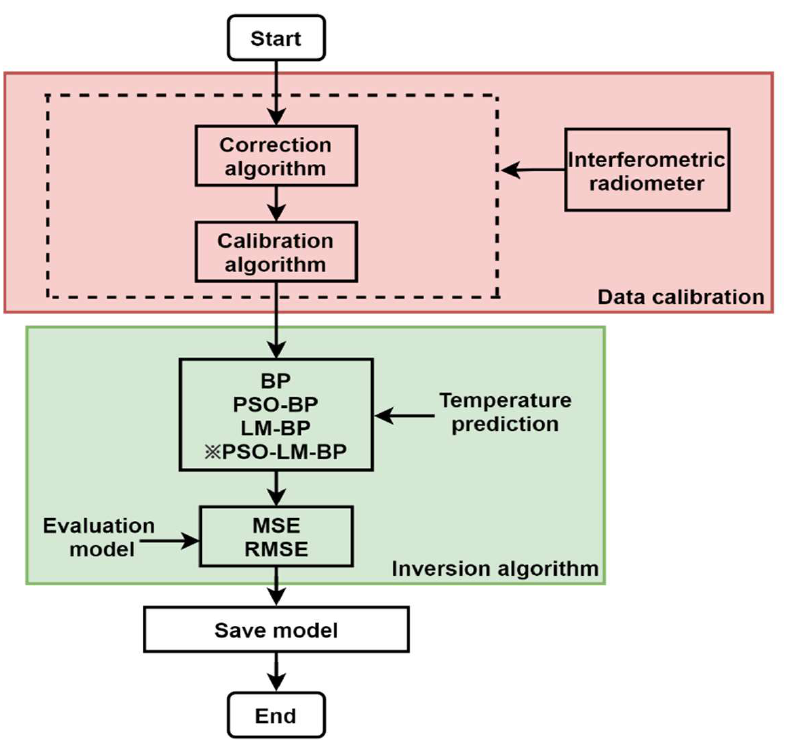
Figure 1. Correlative microwave radiometer calibration and temperature inversion process.